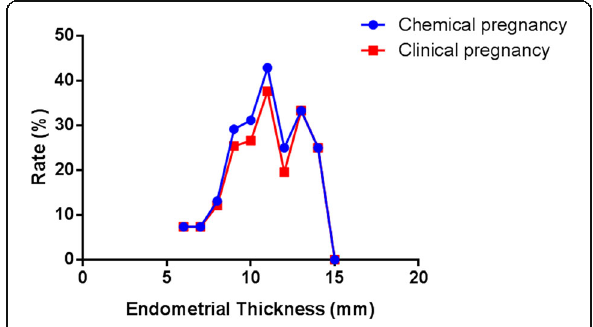
Fig. 1 The relationship between endometrial thickness and pregnancy outcomes